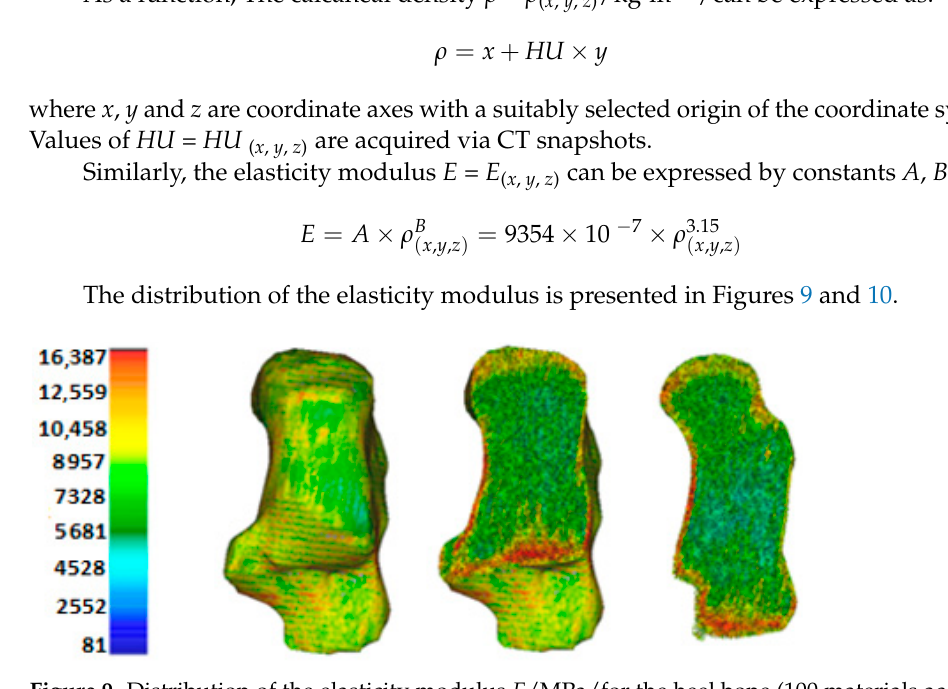
Figure 9. Distribution of the elasticity modulus E /MPa/for the heel bone (100 materials acquired from CT images via Mimics software)–transversal